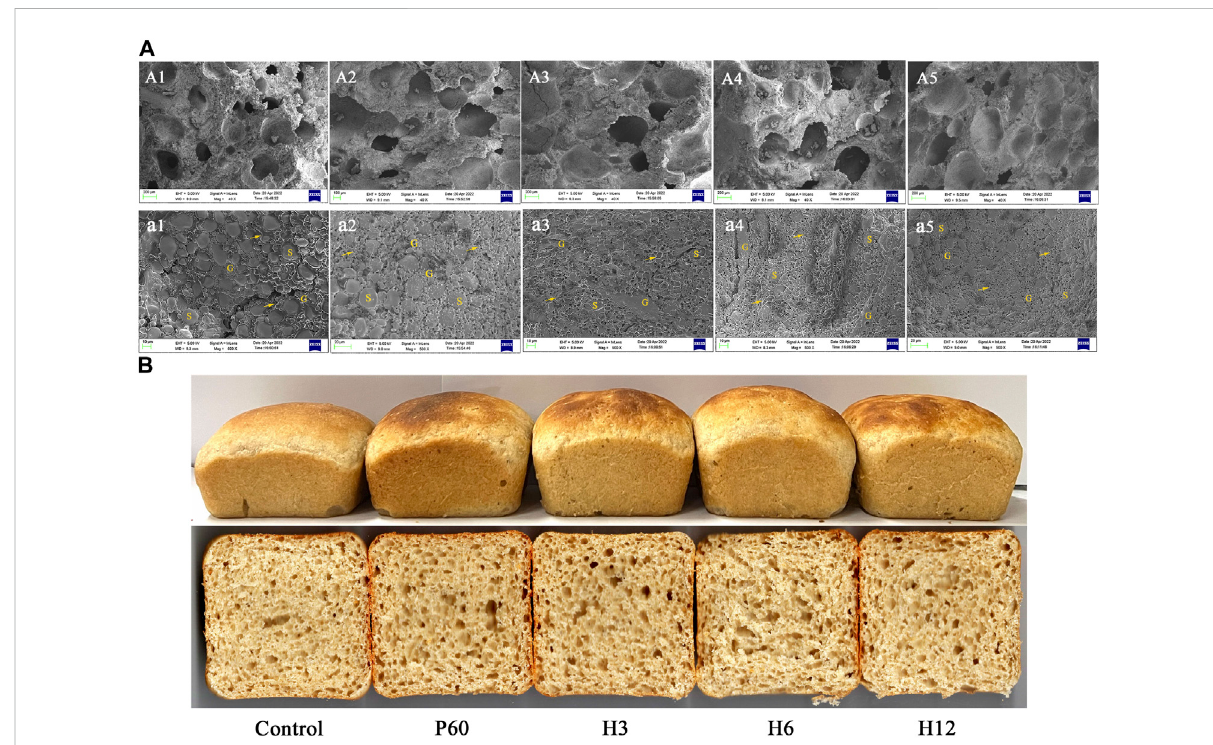
FIGURE 6 (A) : Scanning electron micrographs of fermented dough treated with different enzymes. A1, a1: control samples; A2, a2: dough prepared with 60 mg Pentopan Mono BG per 1 kg wholewheat fl our; A3-A5, a3 – a5: dough prepared with 3, 6, and 12 mg Hmxyn per 1 kg wholewheat fl our; A1 – A5:×40magni fi cation;a1 – a5:×500magni fi cation.S,Gandarrowsrepresentstarchgranules,glutenmatrix,andglutennetwork,respectively. (B) Images of bread with different enzyme treated. Control: control sample; H3 – H12: dough prepared with the addition of 3, 6, and 12 mg Hmxyn per 1 kg wholewheat fl our. P60: dough prepared with the addition of 60 mg Pentopan Mono BG per 1 kg wholewheat fl our.